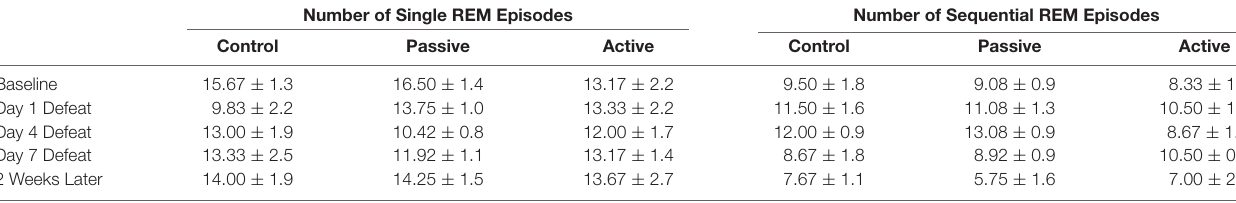
TABLE 1 | Continuity of REM sleep (single vs. sequential episodes of REM) in the light period at baseline, Day 1 Defeat, Day 4 Defeat, Day 7 Defeat, and 2 weeks